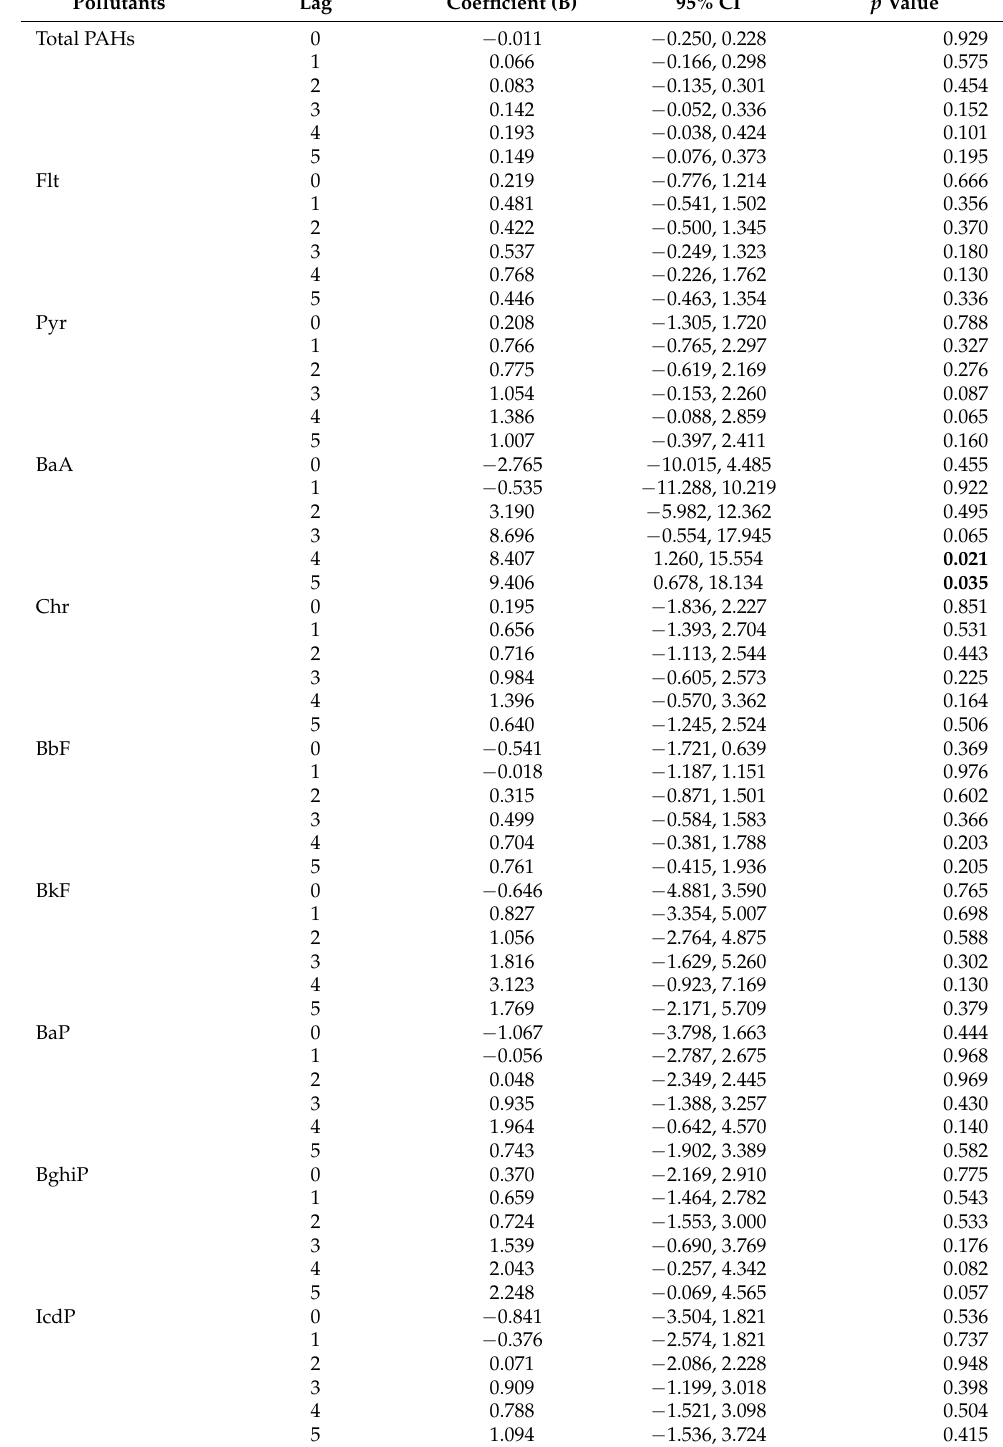
Table 4. Adjusted estimates of cough symptoms by each PAH